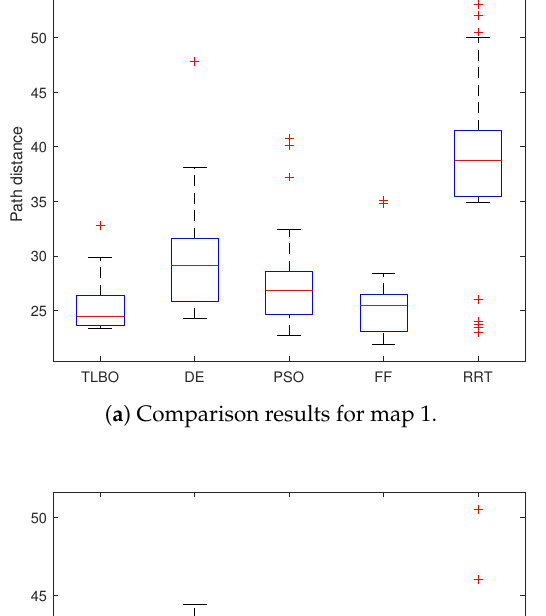
( a ) Comparison results for map 1. ( b ) Comparison results for map 2.